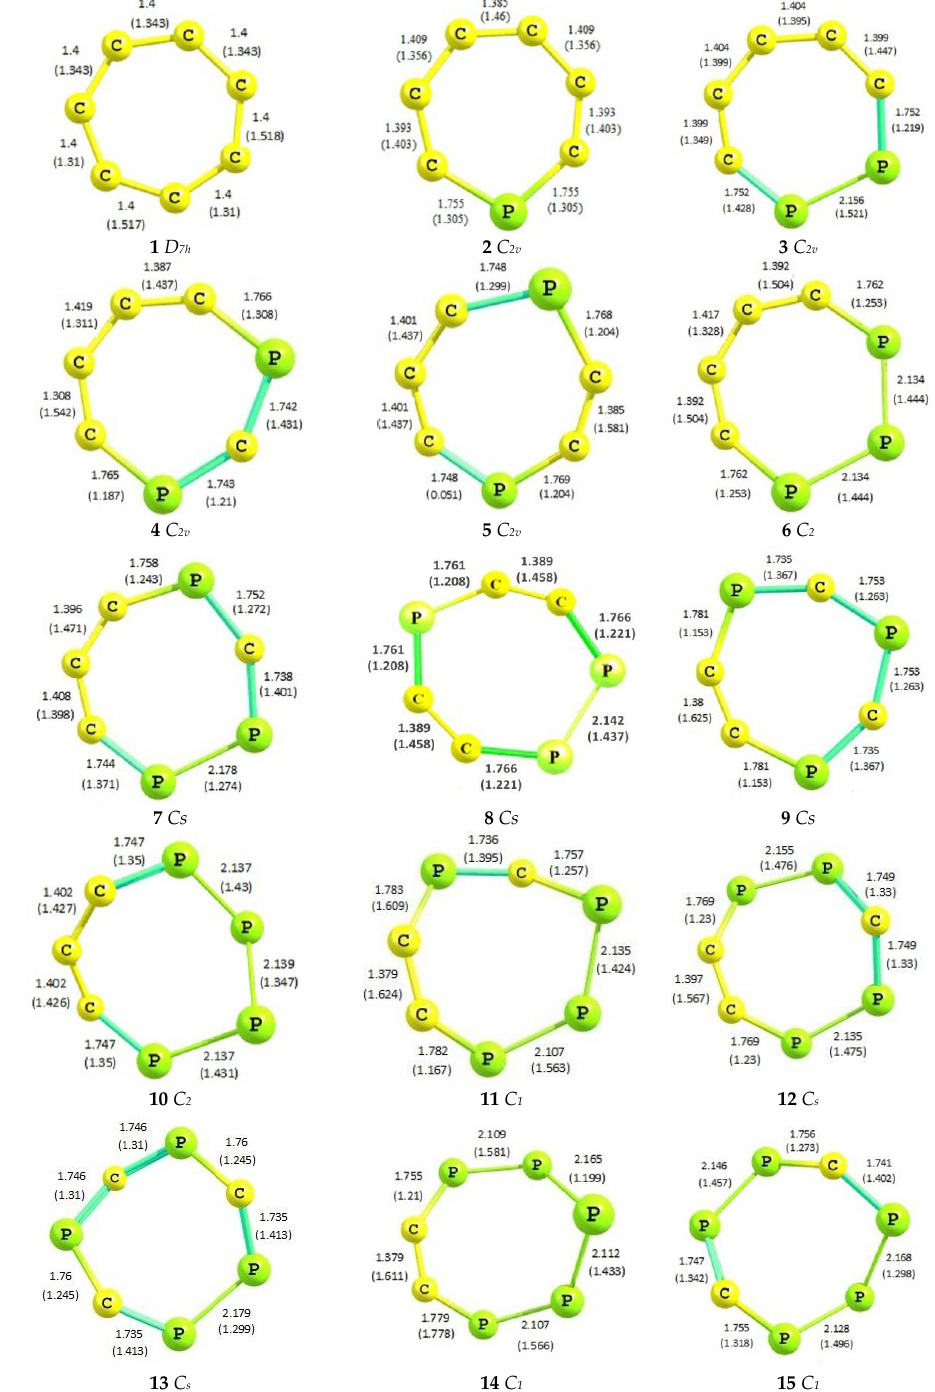
Figure 1. Optimized geometries of tropylium ion and its mono- and poly-phosha analogues at the B3LYP/6-31+G(d) level with bond distances (in Å ) and Wiberg bond indices (in parenthesis). For better visualization, H atoms have been omitted.